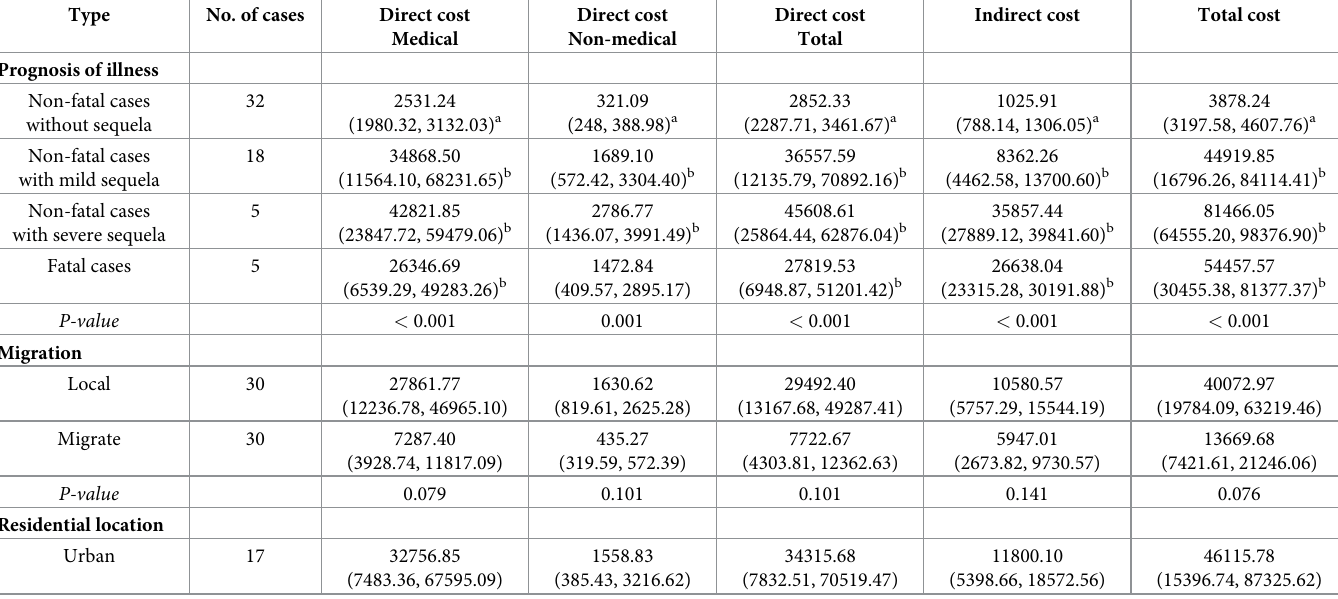
Table 2. Average costs (mean with 95%CI) per JE case (in US$) according to different classification.